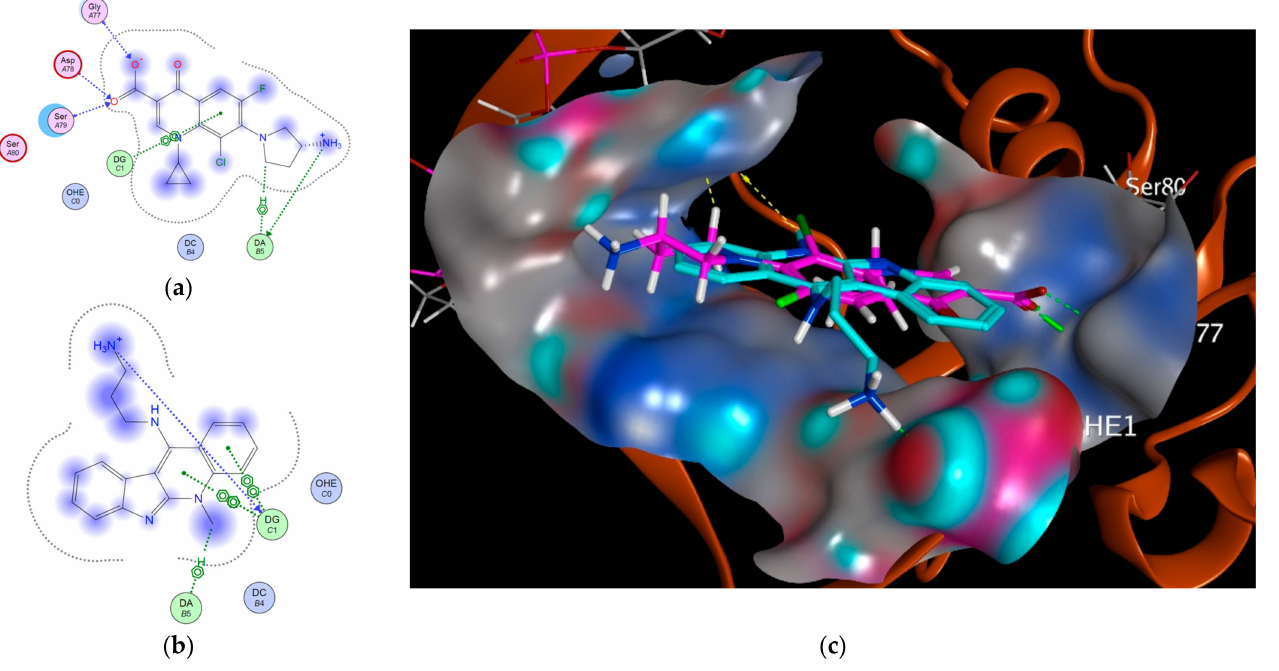
Figure 4. Docking at the target protein pdb:3FOE; ( a ) 2D interaction of protein co-crystalized ligand NFX; ( b ) 2D interaction of APAN; ( c ) surface view of APAN in cyan sticks complexed with the co-crystalized ligand NFX in pink sticks at the site of interaction (H-bonds in green color and hydrophobic pi interactions in yellow